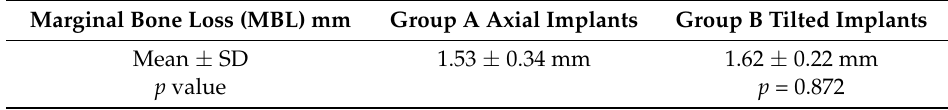
Table 2. Marginal bone loss (MBL) comparison between axial and tilted implants. The groups A and B implants showed similar MBL without significant differences p >